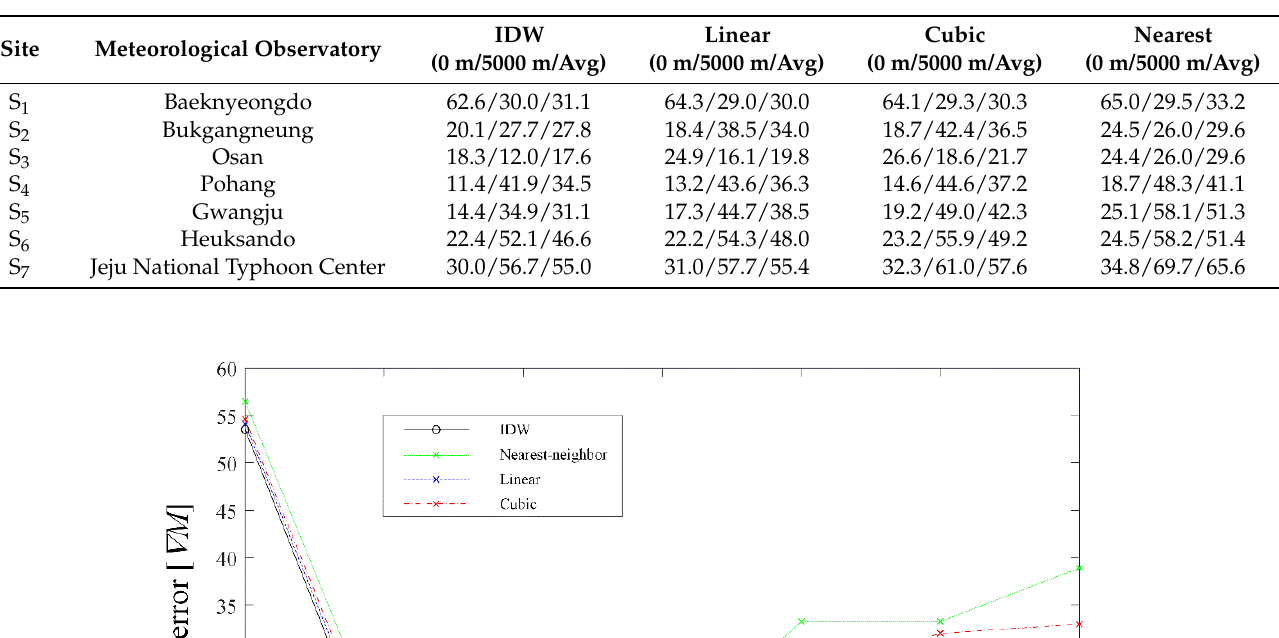
Table 2. RMSE of M results for seven observatories.